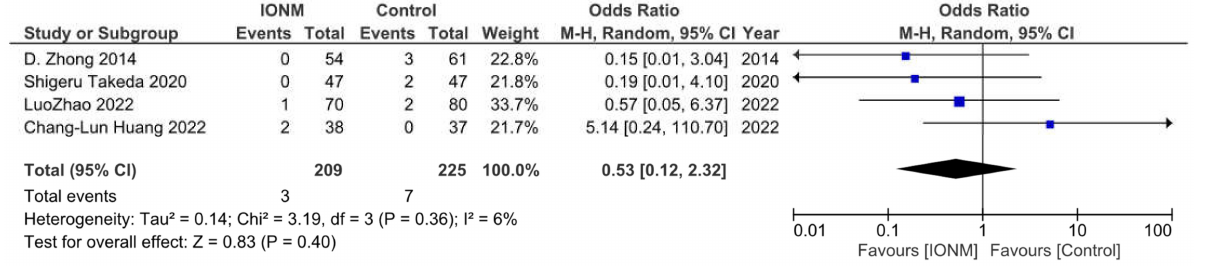
Figure 6. Forest plot of IONM for chylothorax. Abbreviations: IONM—intraoperative neuromonitoring.